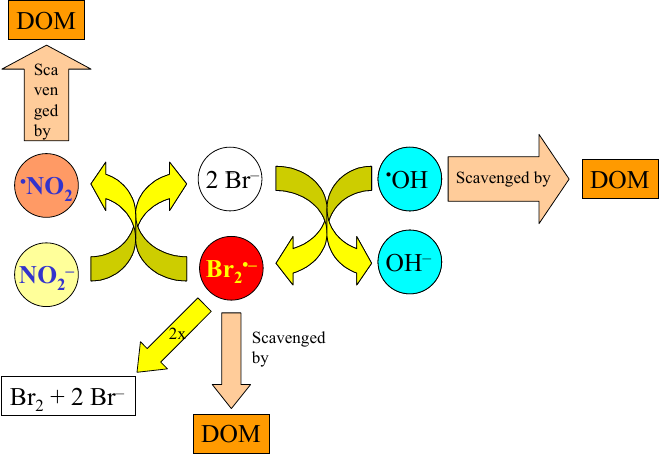
Figure 8. Schematic of the main processes involving Br 2 •− in sunlit saltwater. The thickness of